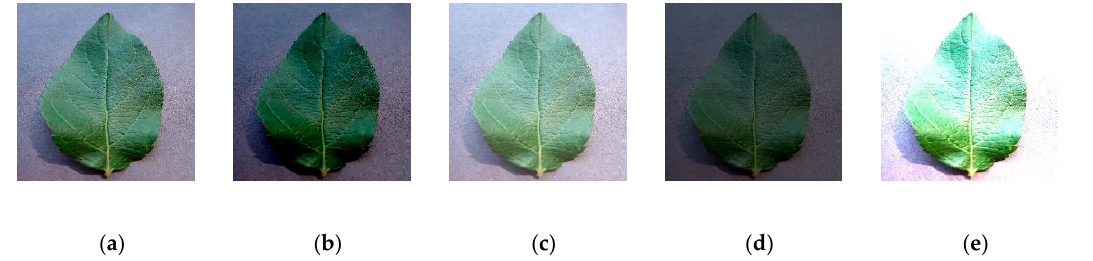
Figure 10. Color enhancement: ( a ) initial, ( b ) low brightness, ( c ) high brightness, ( d ) low contrast, ( e ) high contrast.